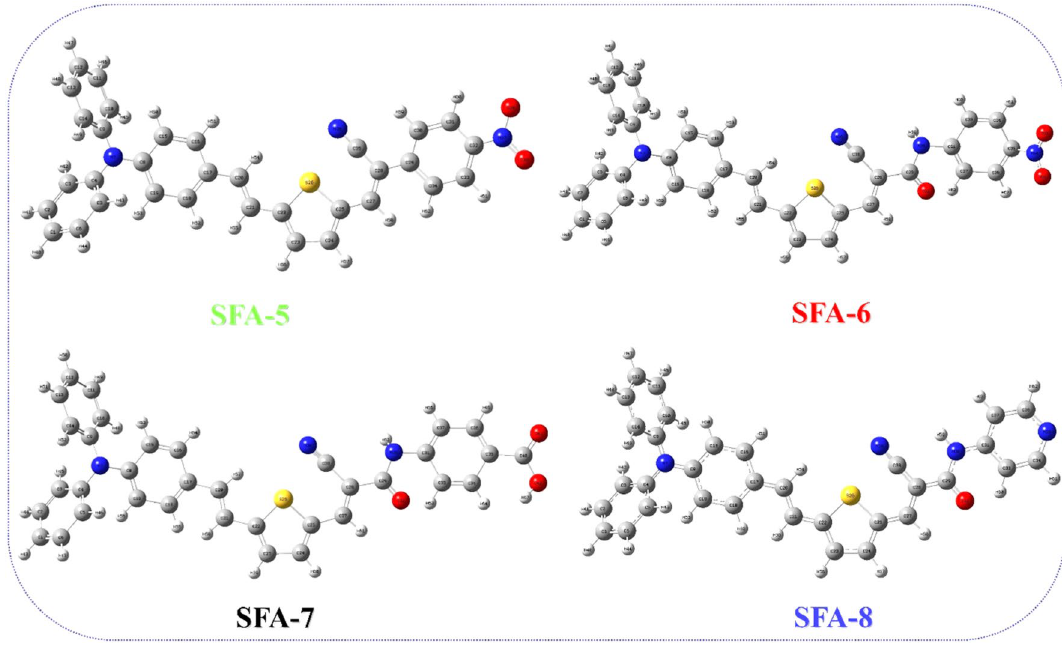
Figure 6. Illustration of the optimized SFA-5–8 dye sensitizer structures.